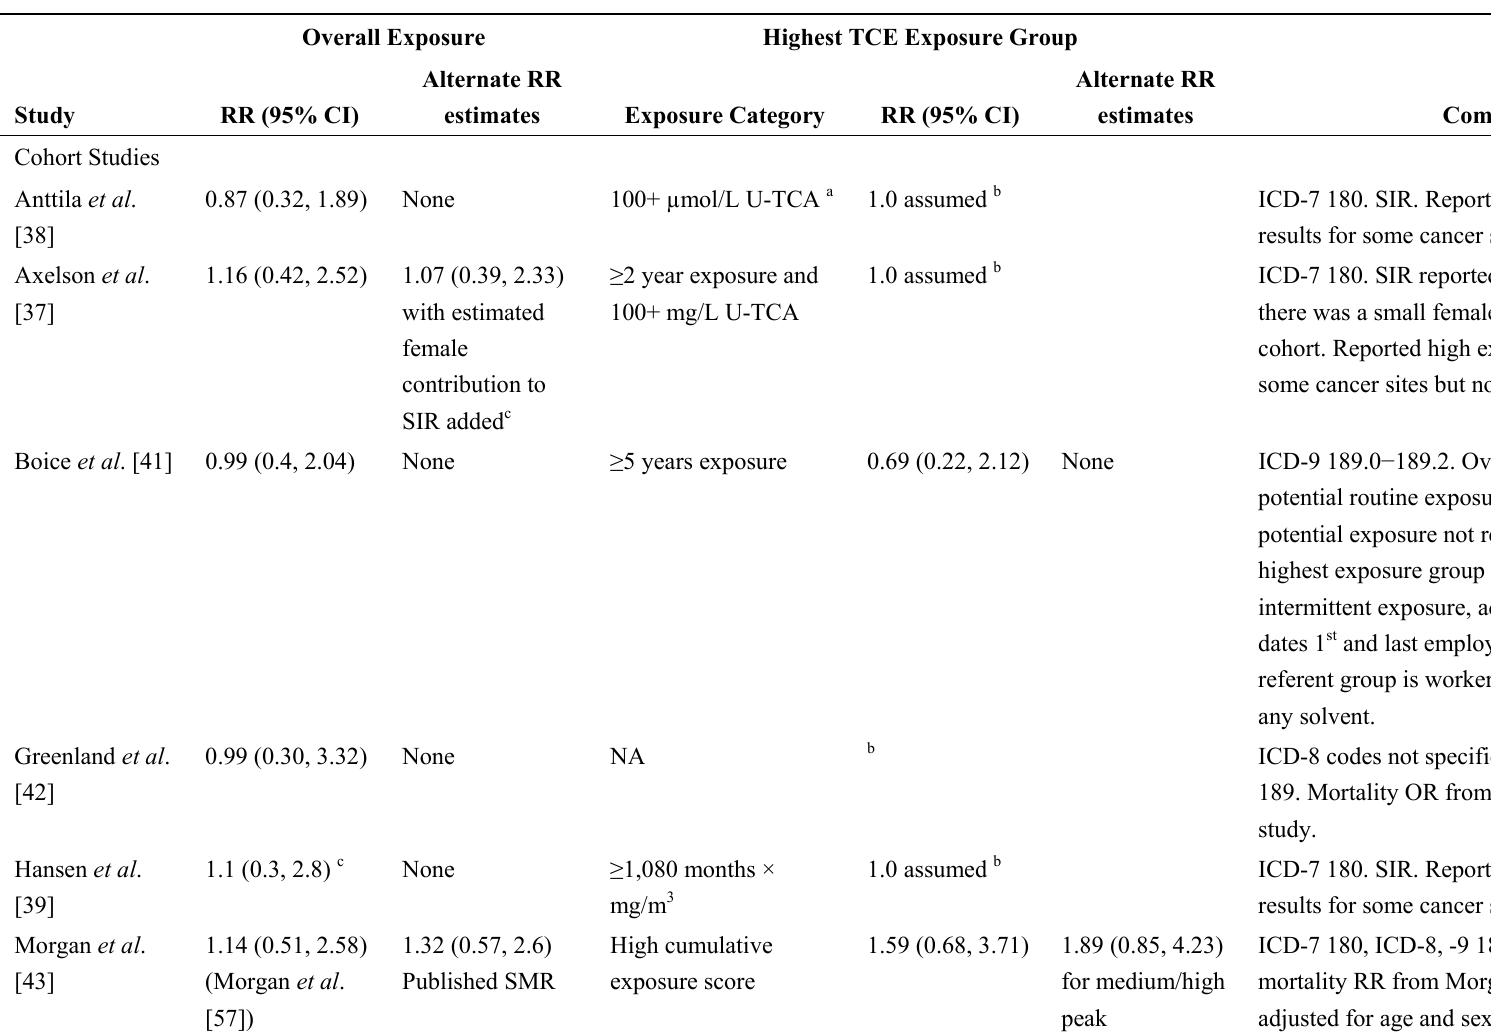
Table 2. RR estimates for kidney cancer associated with TCE exposure (overall and highest exposure group) from cohort and case-control